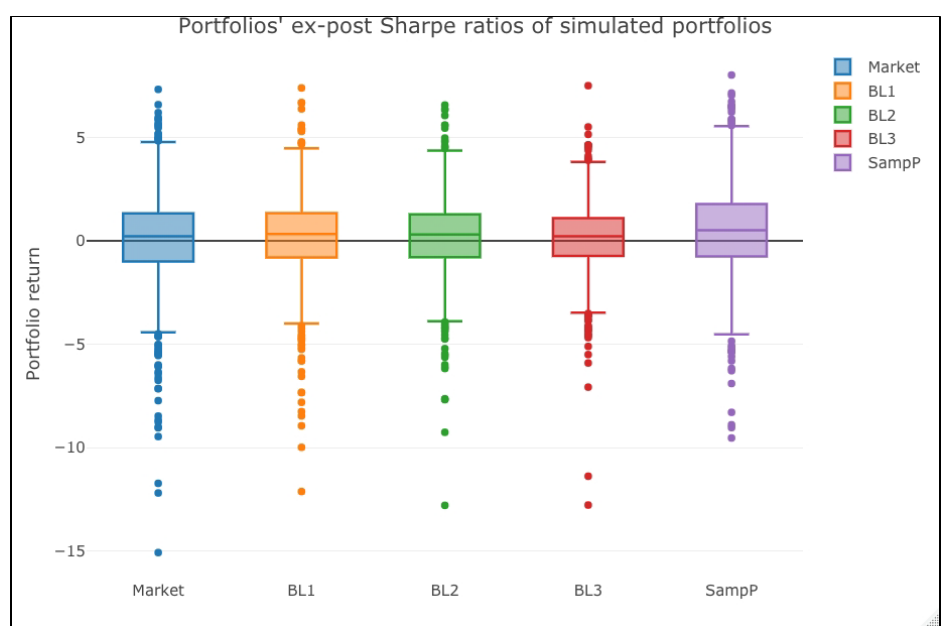
Figure 7. Simulated portfolios’ ex-post Sharpe ratio boxplot. Table 7. One-way ANOVA test of the simulated portfolios’ ex-post Sharpe.